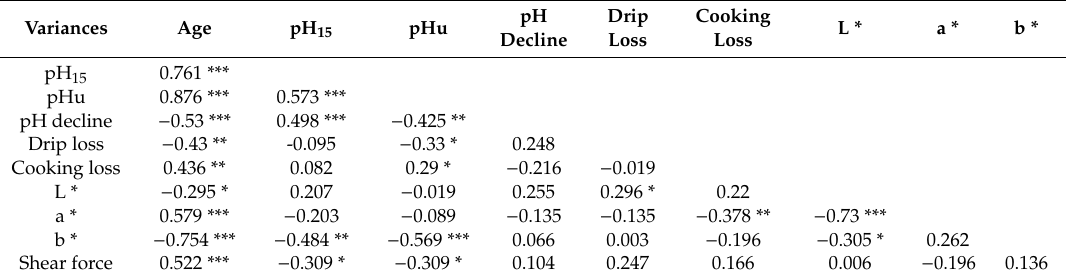
Table 8. Partial correlation coe ffi cients between meat quality traits for Da-Heng meat type birdss.